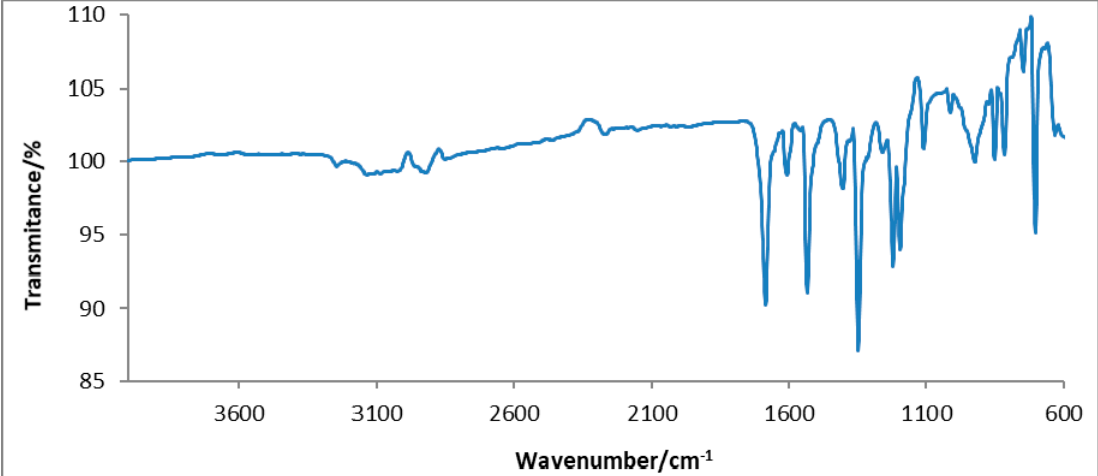
Figure 1. FTIR spectrum of organic ligand.